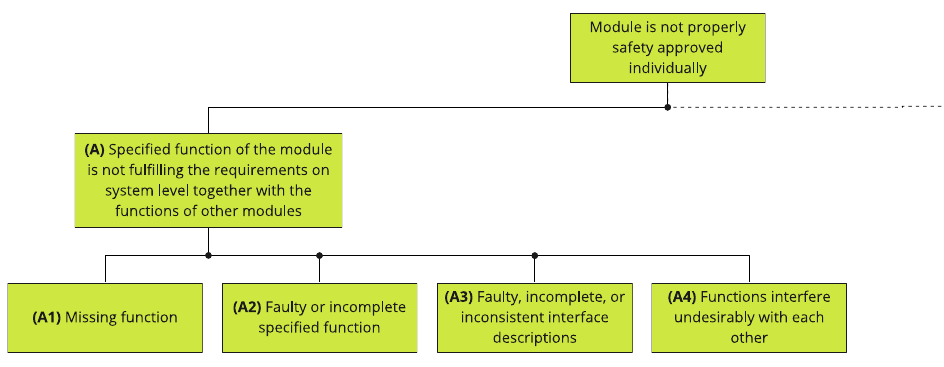
Figure 3. Fault tree of error A. In the architecture, errors are assigned to their location, visualized by small boxes, module 1 and module 2, which are containing the functions F1, F2 and F3 that are receiving and sending information, illustrated by